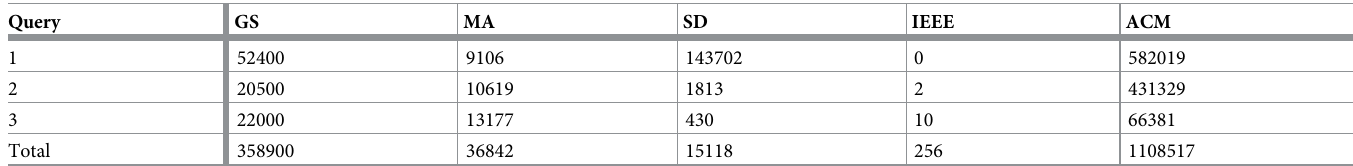
Table 2. Results of the search queries in a number of scientific databases. Acronyms used: GS—Google Scholar, IEEE—IEEE Xplore, MA—Microsoft Academic, SD— ScienceDirect.